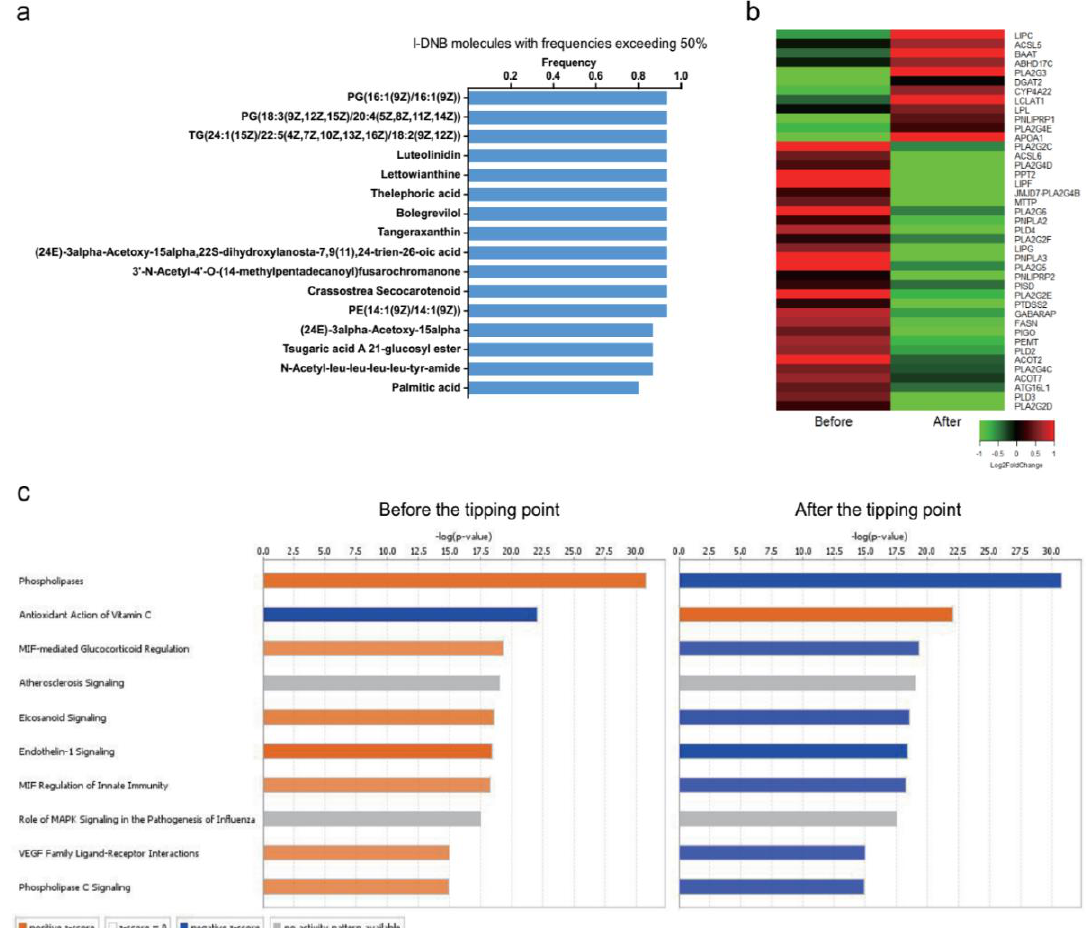
Figure 4. ( a ) The list of l-DNB candidate molecules with frequencies exceeding 50% in Stage A samples. ( b ) The dynamic expression of the l-DNB candidate molecule-related genes before and after the tipping point. Before the tipping point—the average log2 fold change of Stage A group relative to Control group. After the tipping point—the average log2 fold change of Stage A group relative to Stage B group. ( c ) The canonical pathway analysis of the l-DNB candidate molecule related genes. The top 10 enriched pathways are shown.